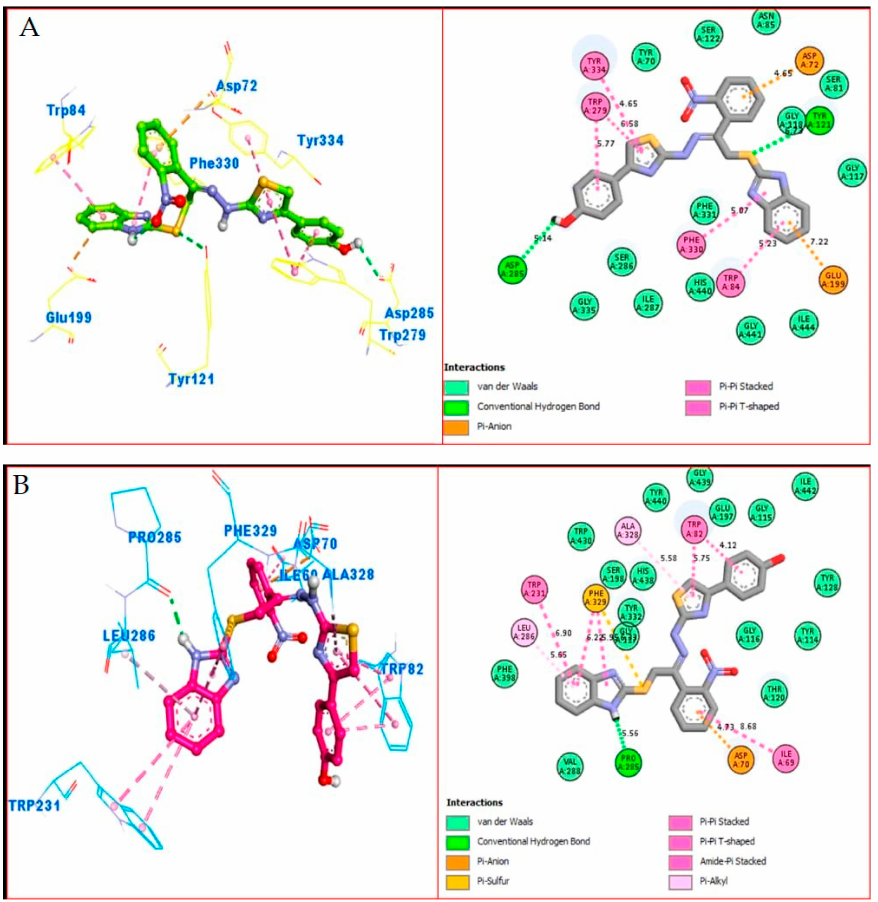
Figure 11. The PLI profile of second most potent analogue ( 16 ): ( A ) analogue 16 against acetyl- cholinesterase (AChE); ( B ) analogue 16 against butyrylcholinesterase (BuChE)